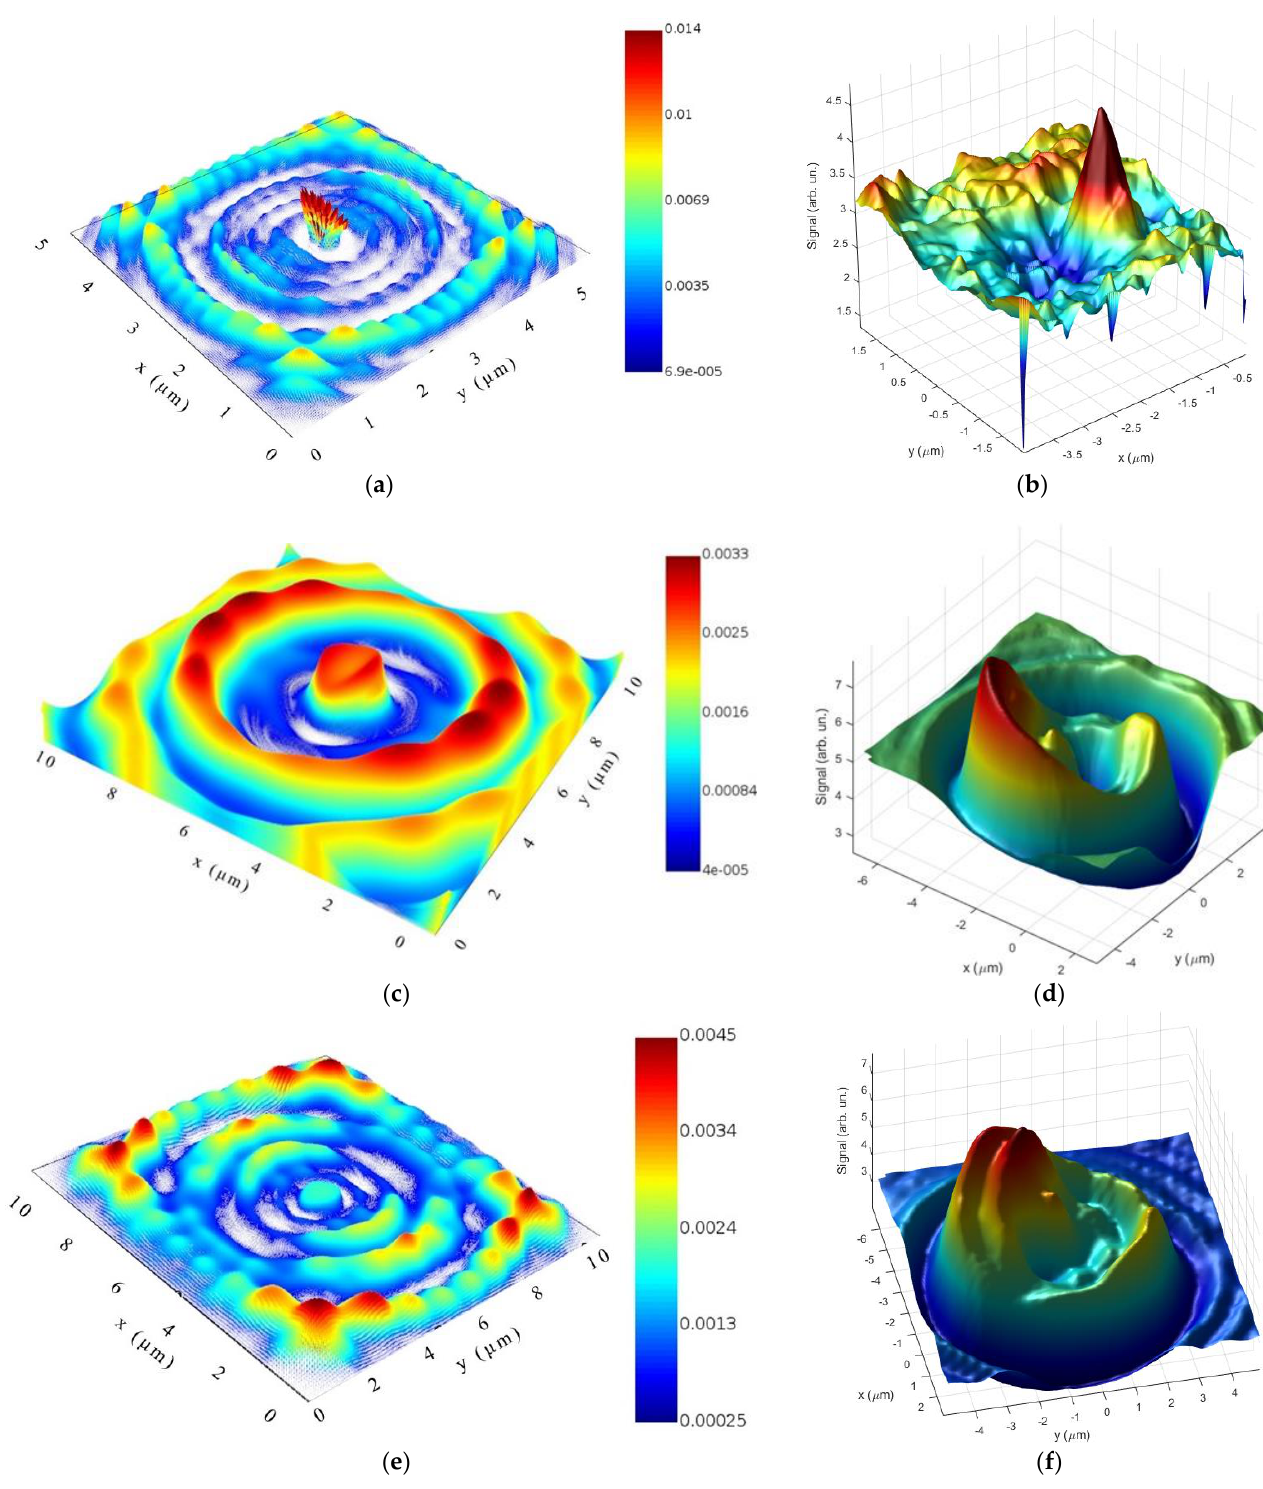
Figure 8. FDTD simulation of electric field distribution of MRZ structure ( left images ) and measured near-field intensity of structure ( right images ) illuminated by: ( a , b ) 490 nm, ( c , d ) 625 nm and ( e , f ) 780 nm LED source.